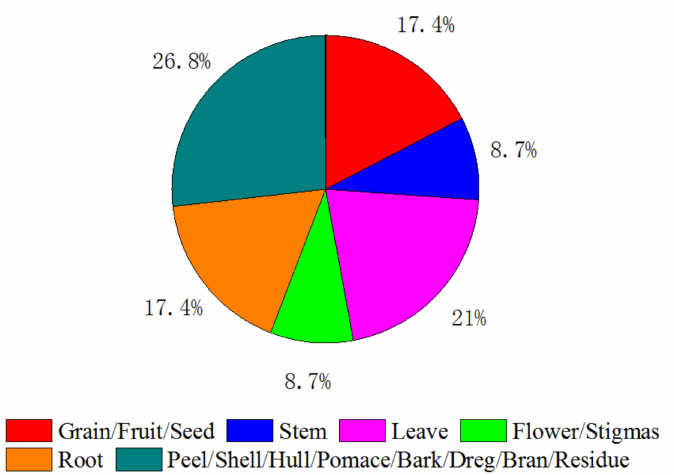
Figure 3. Parts of medicinal herbs extracted by subcritical